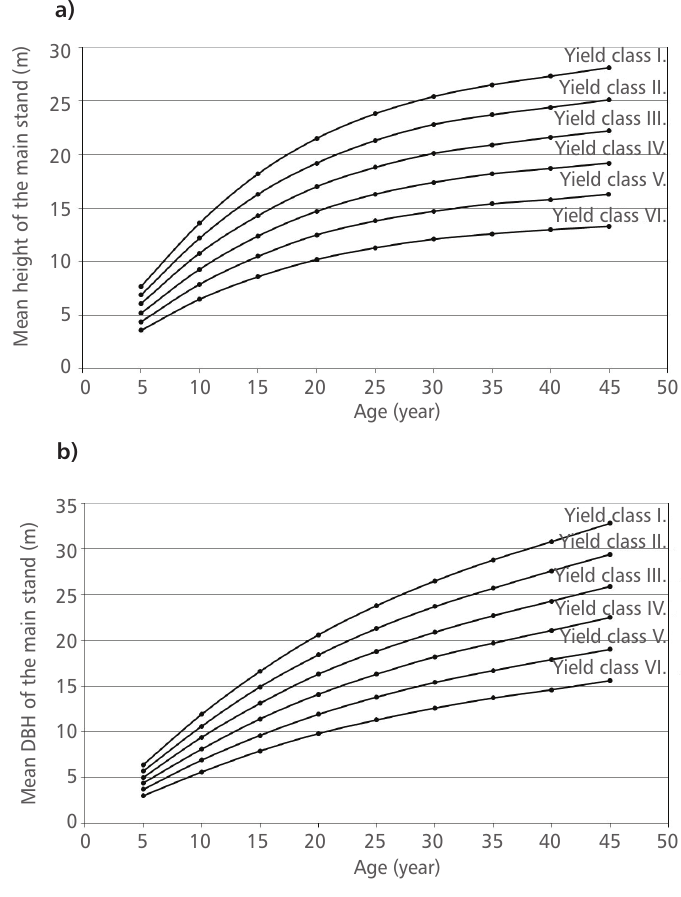
FIGURe 3. a-e. Data of stand structure and yield of black locust ( Robinia pseudoacacia L.) stands as a function of the